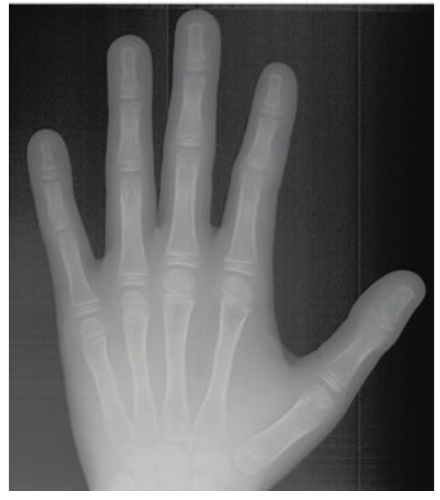
Figure 6: Initial hand-wrist radiograph.